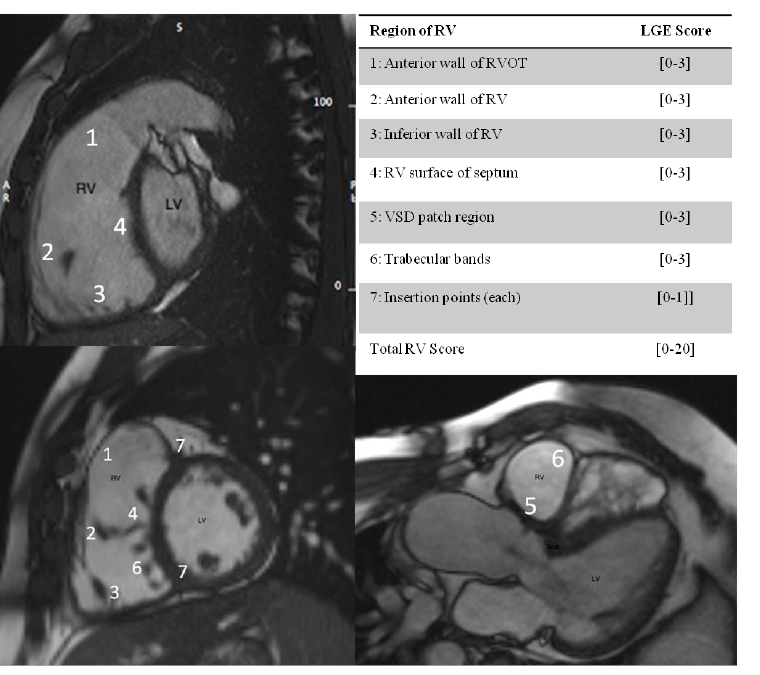
Figure 1. Segmentation system for LGE RV analysis. 1 – 7: RV segments The division of the RV into 7 segments is shown in slices aligned with the RVOT, the LV outflow tract, and the LV short axis, with maximum LGE score per segment in brackets. [0 – 3]: LGE RV SCORE, 0: no linear extent of enhanced myocardium; 1: enhancement of 1 trabeculation; 2: enhancement of 2 to 4 trabeculations; 3: enhancement of more than 4 trabeculations. The insertion points of RV and LV (marked 7) were each scored 0 for absence and 1 for presence of LGE. The maximum score was 20.